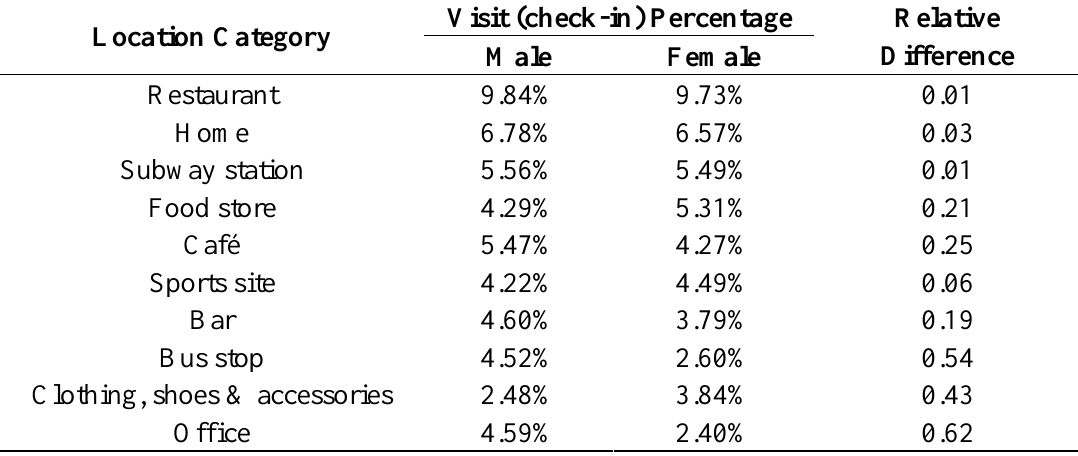
Table 4. Gender differences in percentages of aggregated numbers of visits to distinct location